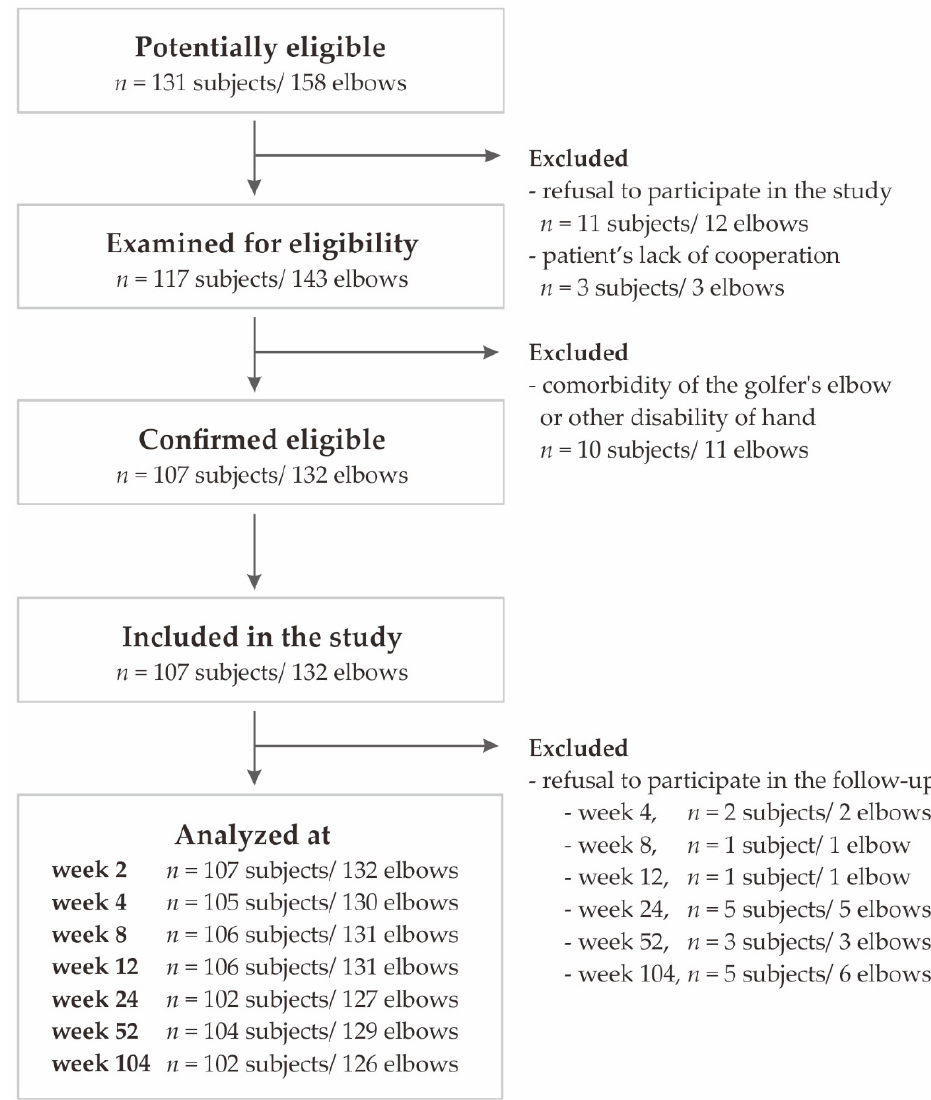
Figure 1. Flowchart of the study selection.